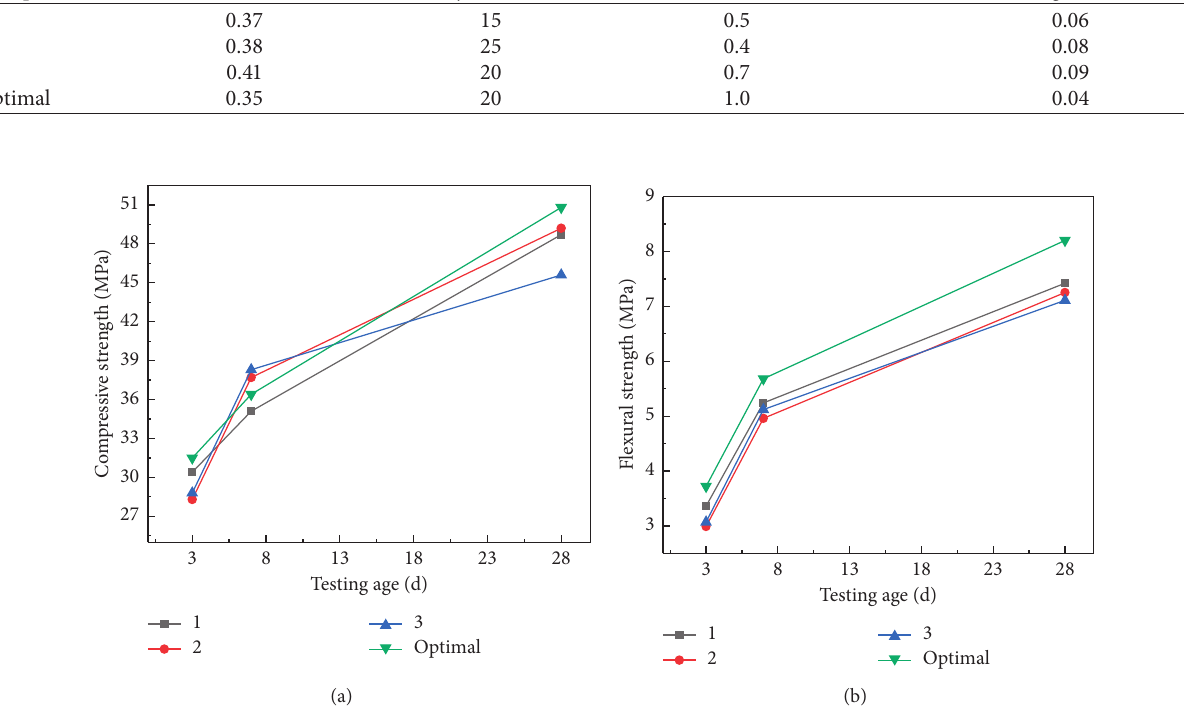
Figure 7: Mechanical properties of the contrast groups. Table 12: The durability of contrast groups.